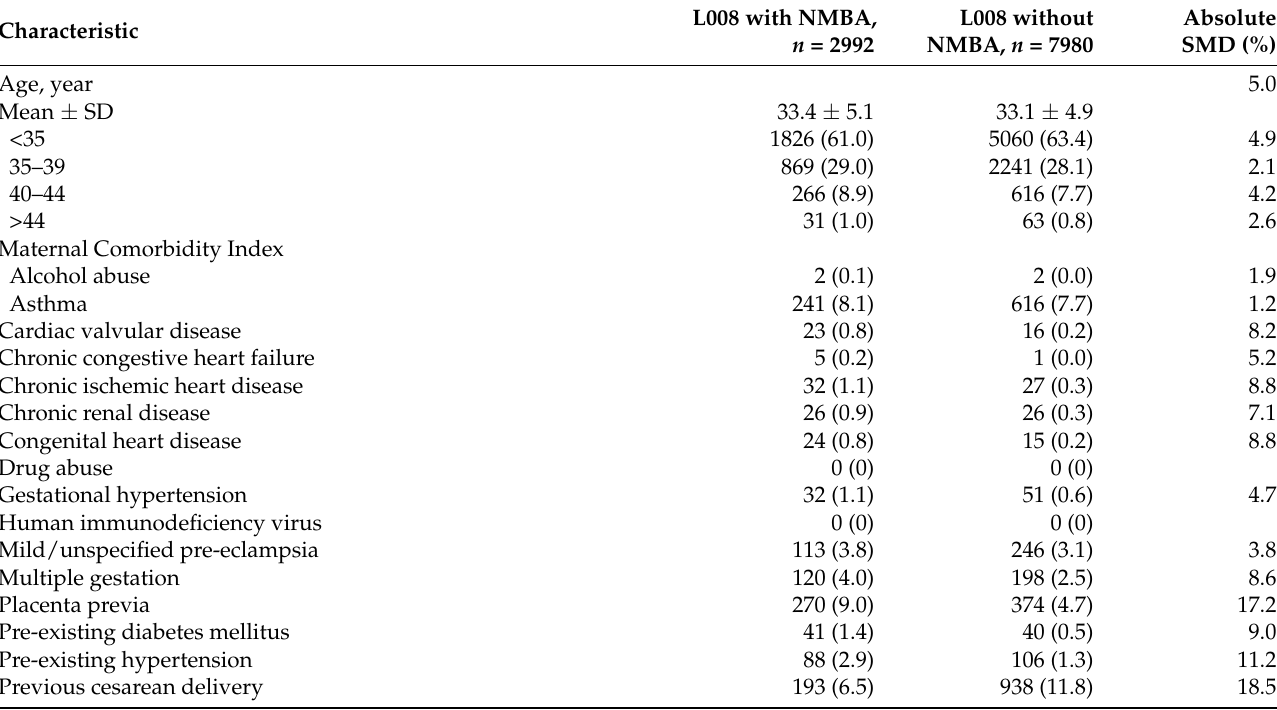
Table 1. Patient and medical facility characteristics of the study cohort with general anesthesia claim code (L008) according to the use of neuromuscular blocking agents